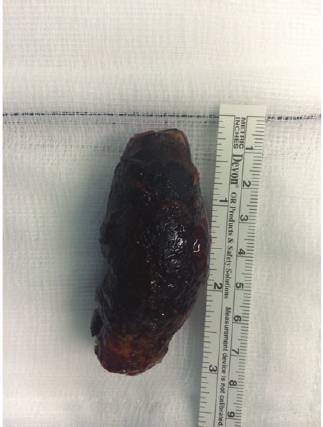
Figure 3: Photograph of the large 7cm gallstone removed from the transverse colon.